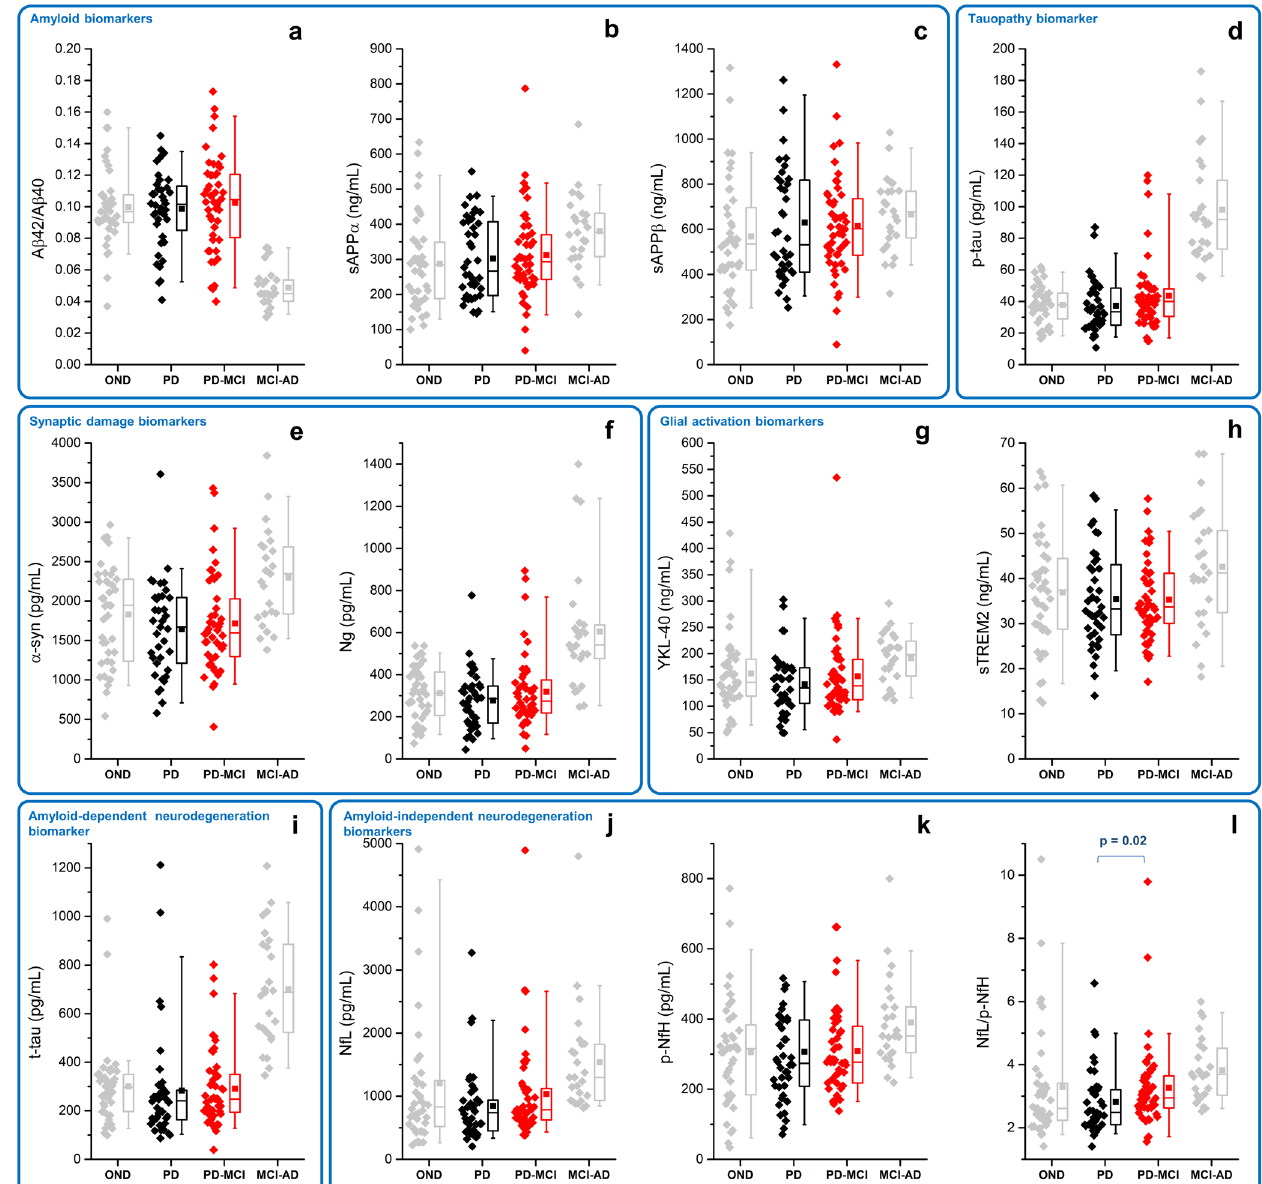
Fig. 1 Box plots relative to biomarkers measured in PD-MCI, PD-CN, MCI-AD and OND. a – c amyloid biomarkers: A β 42/40, sAPP α , sAPP β . d tauopathy biomarker: p-tau. e , f synaptic damage biomarkers: α -syn, Ng. g , h glial activation biomarkers: YKL-40, sTREM2. i amyloid- dependent neurodegeneration biomarker: t-tau. j – l amyloid-independent neurodegeneration biomarkers: NfL, p-NfH, NfL/p-NfH. Boxplots summarize the distribution of the data, where the box represents the interquartile range, the horizontal line inside the box represents the median, and the fi lled square within the box represents the mean. The whiskers extend to the minimum and maximum values within 90% of the data range. P-values have been corrected for multiple group comparisons. MCI-AD mild cognitive impairment due to Alzheimer ’ s disease, OND healthy cognitive patients with other neurological disorders, PD-CN cognitively normal Parkinson ’ s disease, PD-MCI Parkinson ’ s disease with mild cognitive impairment. A β 42/A β 40 β -amyloid 1-42/1-40 ratio, NfL neuro fi lament light chain, Ng neurogranin, p-NfH phosphorylated neuro fi lament heavy chain, p-tau phosphorylated-tau, sAPP α soluble amyloid precursor protein α , sAPP β soluble amyloid precursor protein β , sTREM2 soluble triggering receptor expressed on myeloid cells 2, α -syn total α -synuclein, t-tau total tau, YKL-40 chitinase-3-like protein